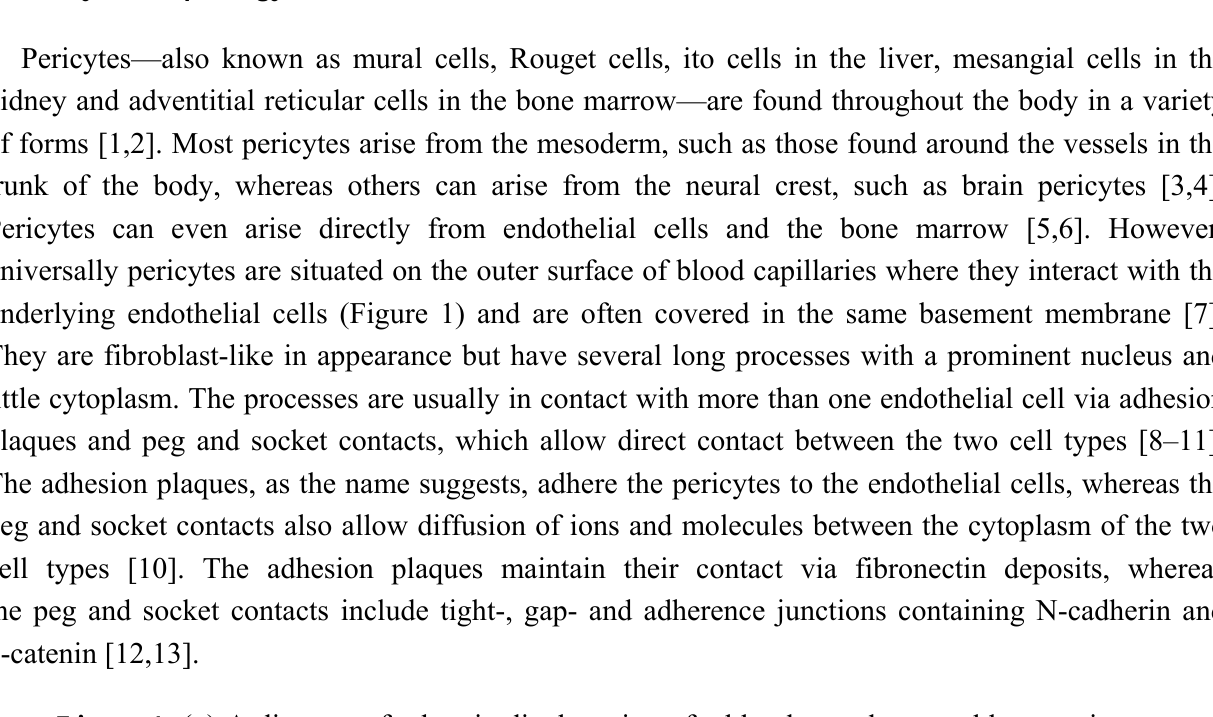
Figure 1. ( a ) A diagram of a longitudinal section of a blood vessel covered by a pericyte; ( b ) A cross-sectional diagram of a blood vessel showing the endothelial cell and pericyte interaction with a common basement